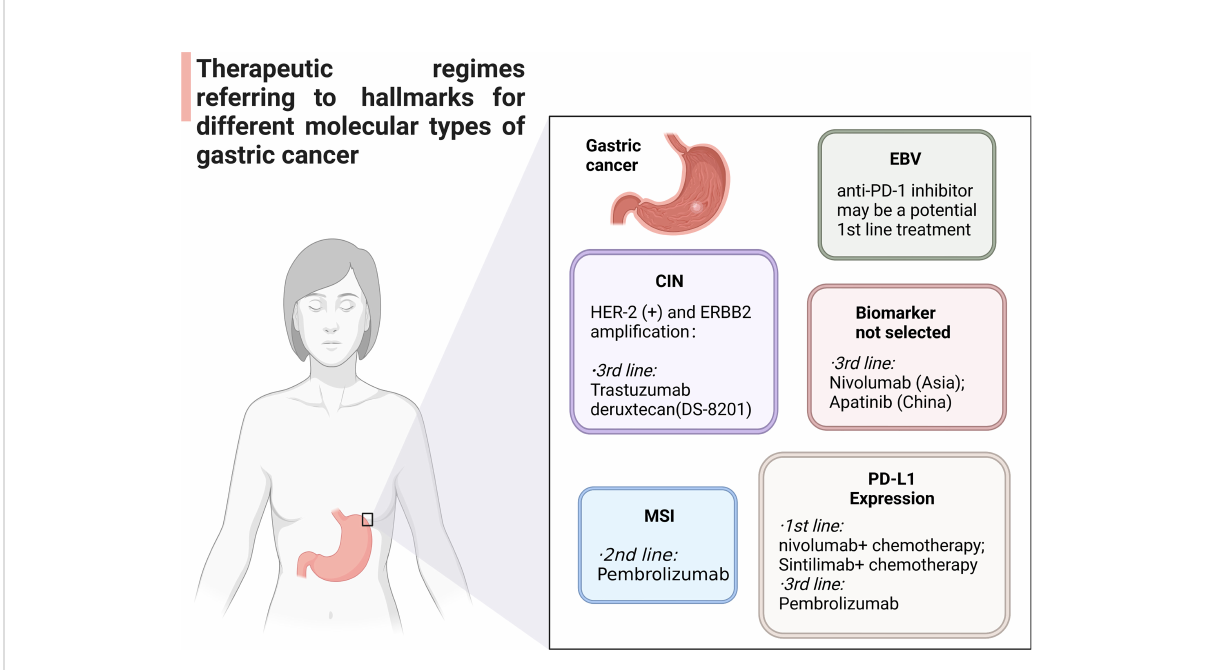
FIGURE 3 Anti-PD-L1/PD-1 regimens in different molecular typing of GC